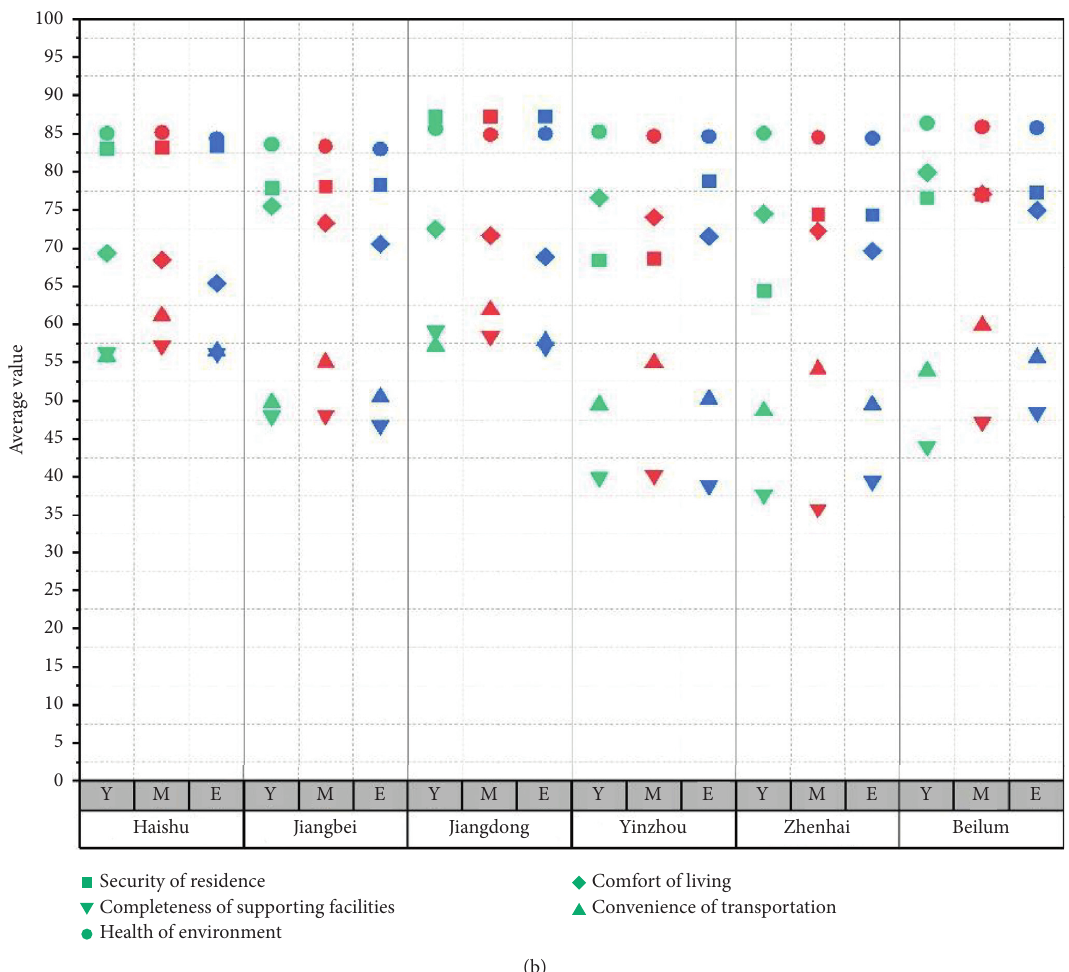
Figure 5: Average value of indicators for each administrative district considering the preferences of different age groups. Y represents the youth group, M represents the middle-aged group, and E represents the elderly group. (a) The average value of livability index. (b) The average value of second-level indicators. Table 4: The classification statistics of the livability index considering the preferences of different age groups. The preferences of the Grade